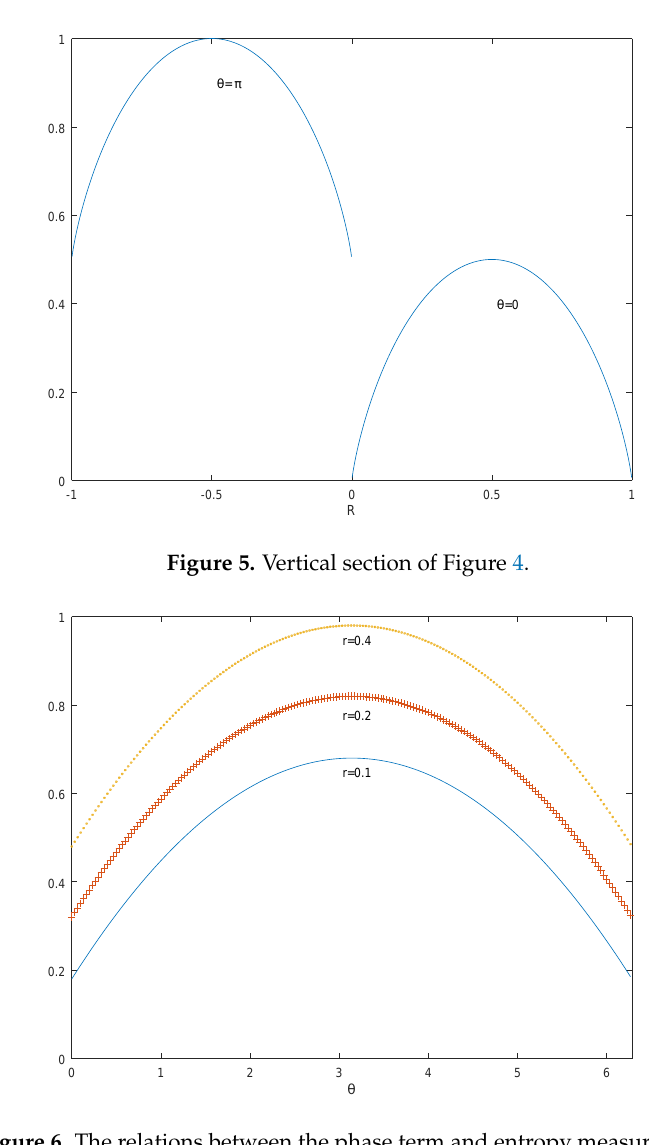
Figure 6. The relations between the phase term and entropy measure of e 4